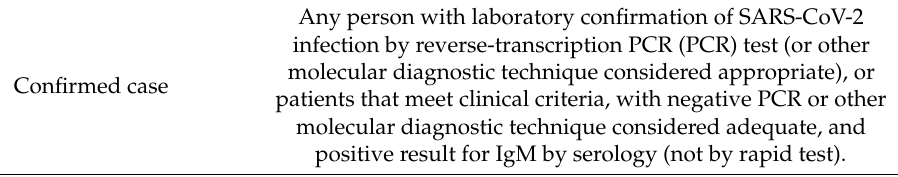
Table 6. COVID-19 case definition, according to the current protocol at the time of the study